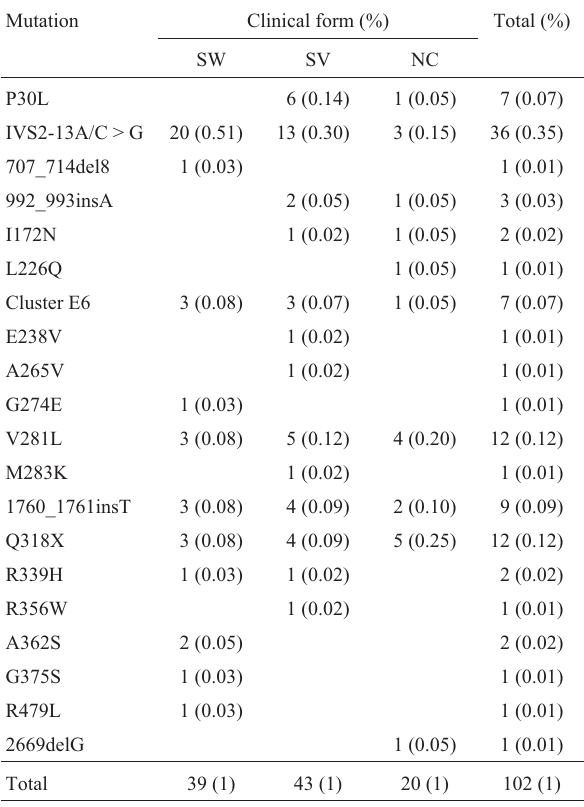
Table 1 - Distribution of the most common mutations found in Brazilian patients from the Amazon region for the different clinical forms of 21-hydroxylase